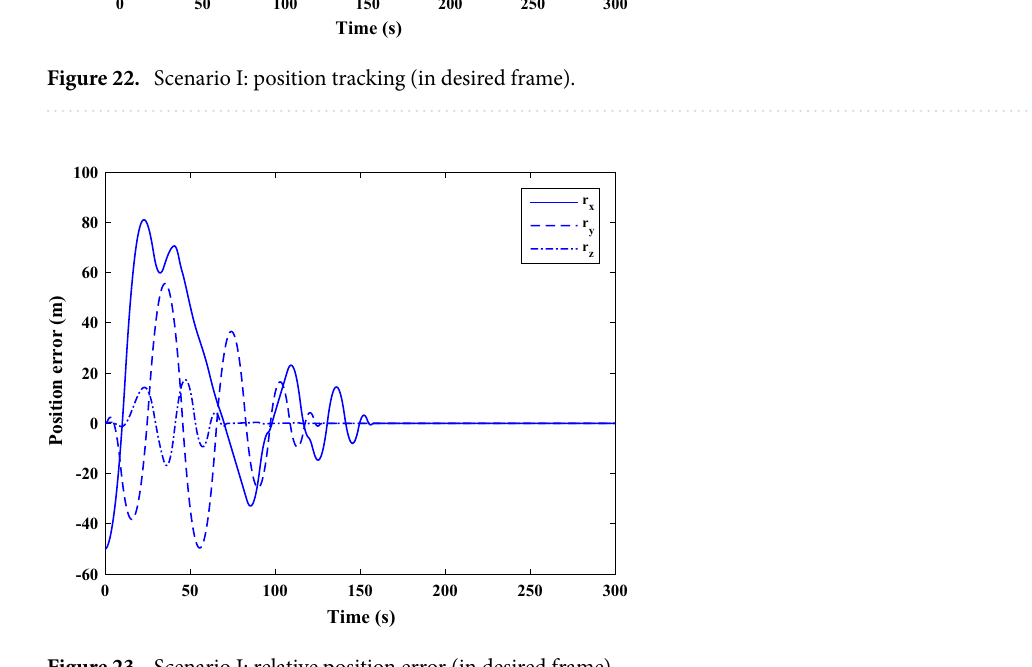
Figure 23. Scenario I: relative position error (in desired frame).